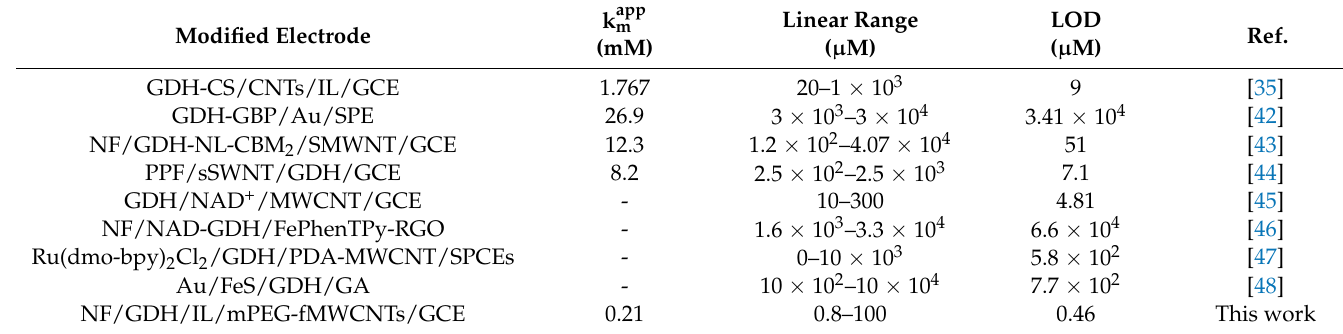
Table 1. Comparison of several glucose dehydrogenase biosensors.